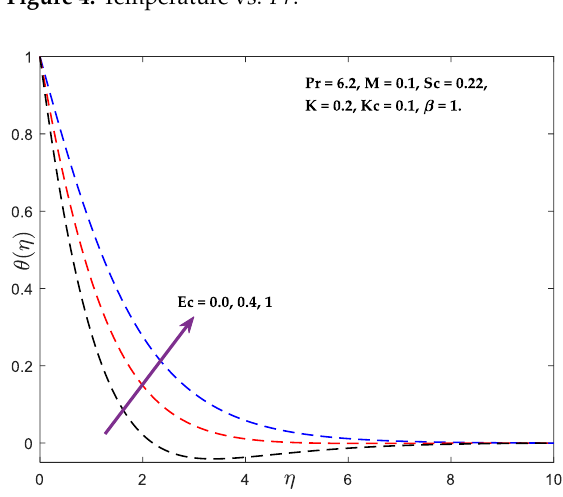
Figure 5. Temperature vs. 𝐸𝑐 .